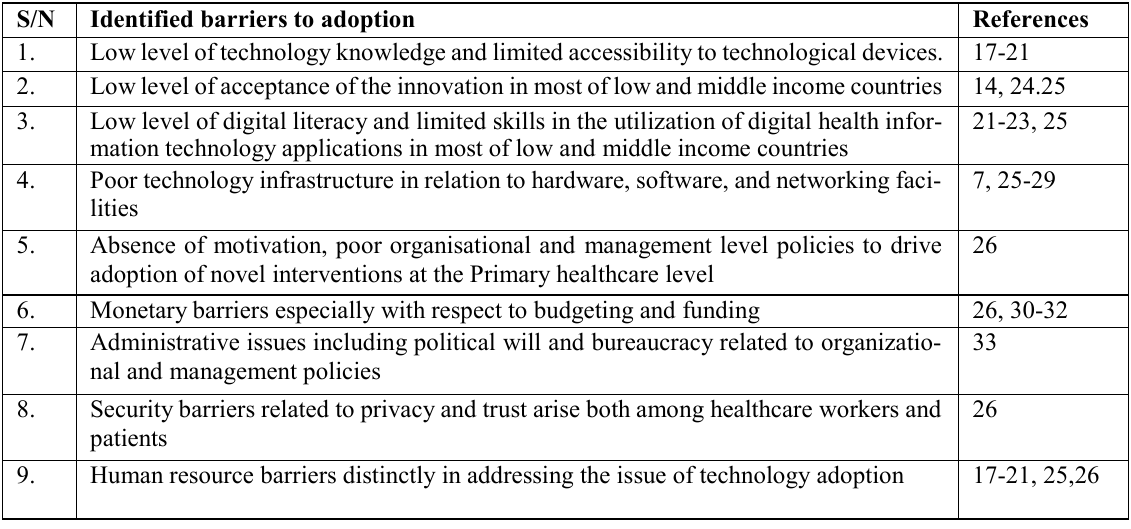
Table 1: Identified barriers to adoption and utilization of digital health information tech- nology applications in most of low and middle income